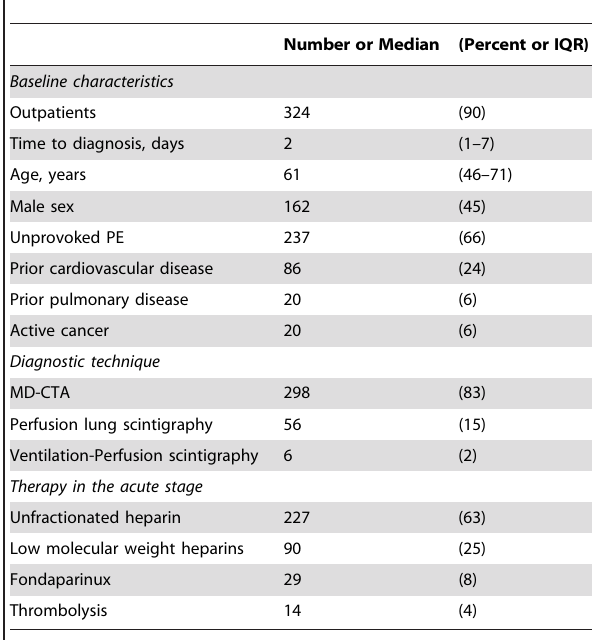
Table 2. Baseline characteristics of 360 patients with pulmonary embolism (Firenze